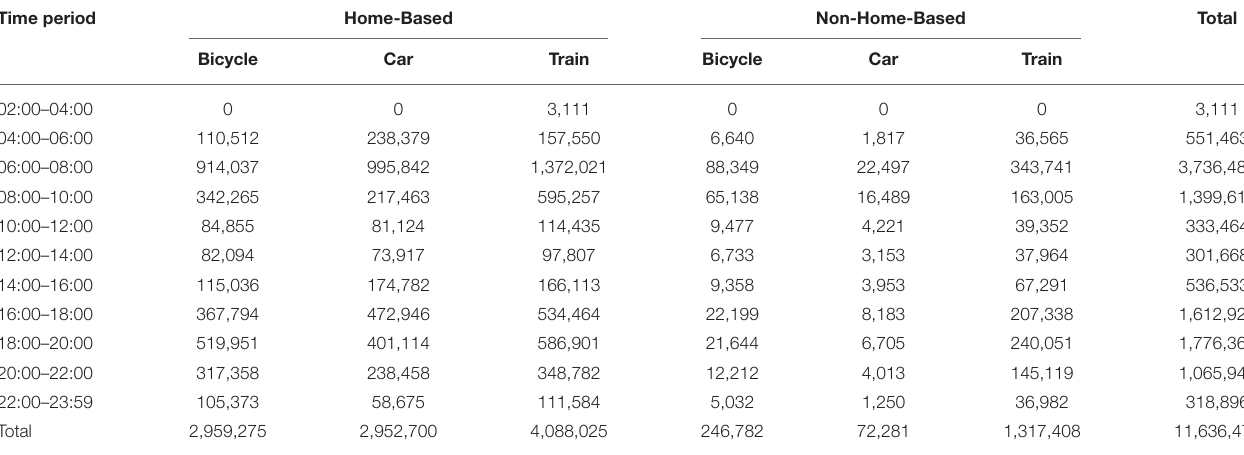
TABLE 3 | Total number of trips in observed origins–destinations (ODs) by time period, purpose, and transport mode. Time